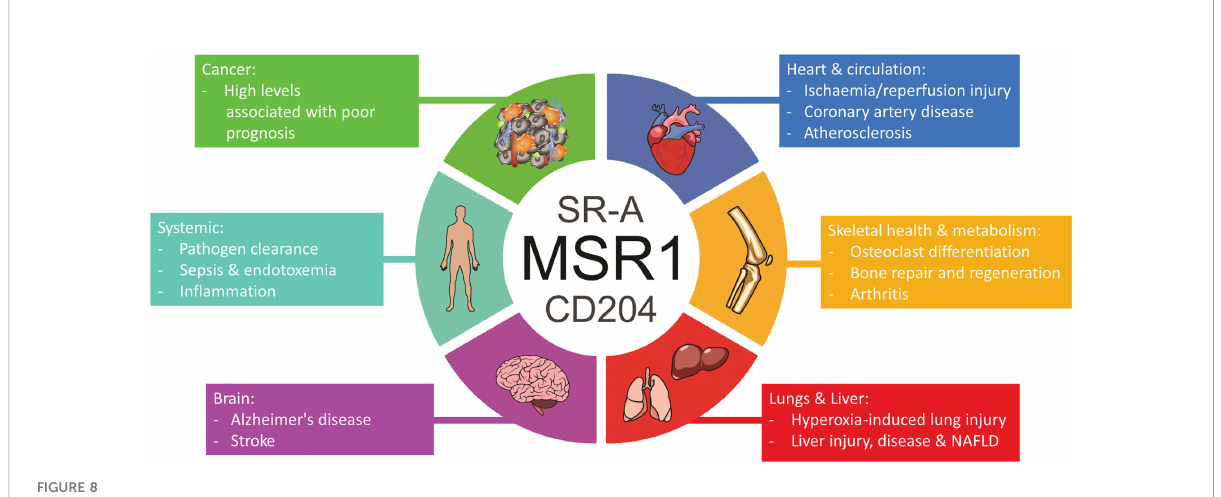
FIGURE 8 Overview of the involvement of MSR1 in health and disease